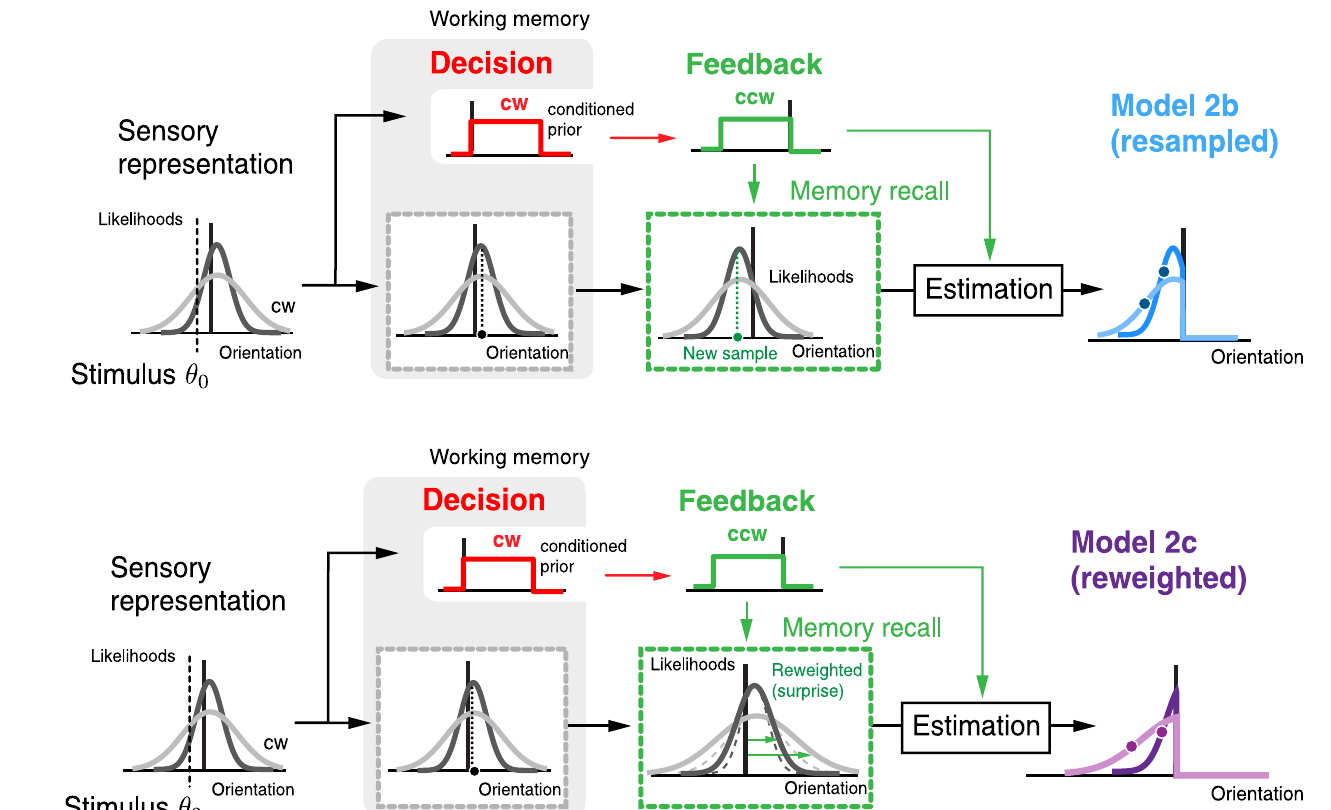
Fig 9. Hypothesis 2—Potential effects of receiving negative feedback on memory recall and estimation. (A) Model 2b (resampled) is identical to Model 2a (flip decision) except that it assumes sensory measurements are resampled from working memory until a new sample lies on the correct side of the reference orientation (i.e. is consistent with feedback). A new likelihood function based on this sample is then combined with the updated categorical prior to compute a Bayesian estimate. (B) Model 2c (reweighted) assumes that the level of surprise the observer experiences about the feedback will cause a reweighting of the sensory evidence: The larger the surprise of being wrong the more the observer reduces their belief in the sensory evidence in the estimation process. We modeled this belief change process by scaling the likelihood width proportionally to the level of surprise, measured as the divergence in beliefs between expected and resulting decision outcome. See Methods for details.